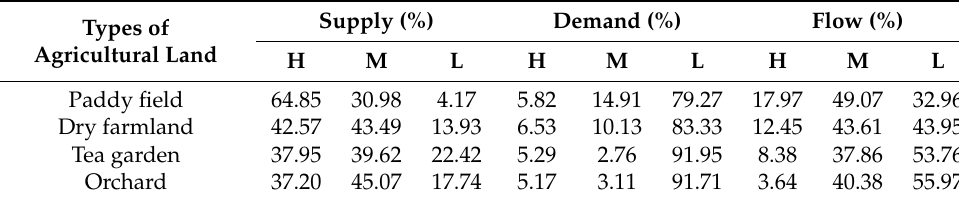
Table 3. Distribution of agricultural CES values for different agricultural land use types.